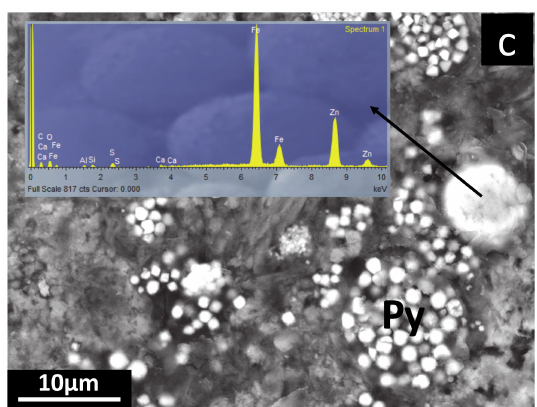
Figure 3. Electron Microscope images of the sediments from La Playa dam. ( a ) Back scattered electron image of alternating bands of microlaminated organic matter-rich layers (OM) and very fine-grain-sized clay-rich layers (CM). ZnS appears as dispersed small-sized particles and crusts. ( b ) Low magnification transmission electron microscope image of the sediments from La Playa dam showing the presence of pseudohexagonal crystals of kaolinite and very fine grain sized flakes of I-DV crystals and smectite. ( c ) Smelting particle containing Fe and Zn near pyrite framboids in organic matter-rich sediments.